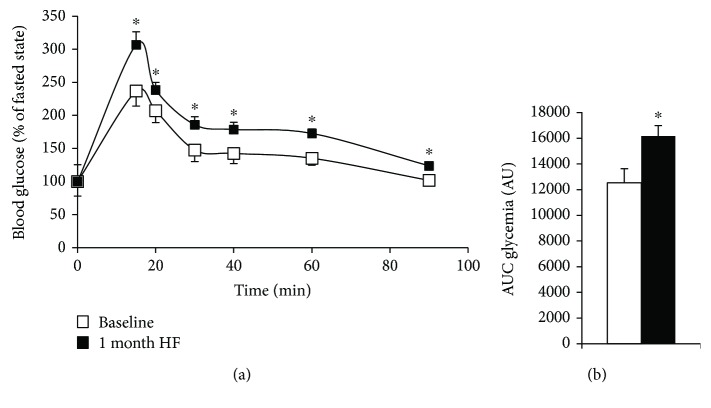
Glucose tolerance test scores. (a) Glycaemia expressed in percentage of basal glycaemia and (b) area under the curve (AUC) during glucose tolerance test of 16 male Sprague-Dawley rats before (baseline, white squares) and after 4 weeks of an ad libitum high-fat diet (black squares). Data are expressed as mean ± SEM. Significant difference: ∗p < 0.05 versus baseline.